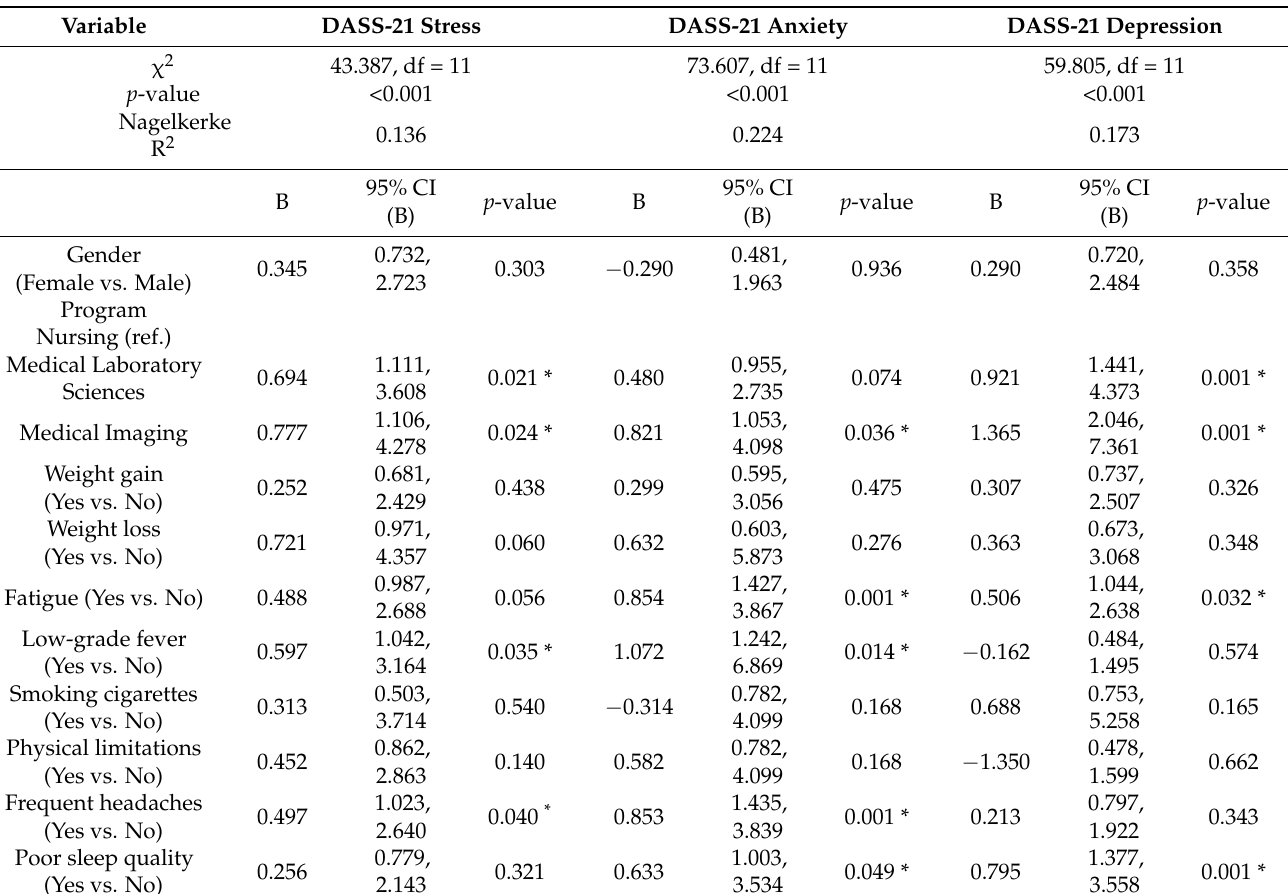
Table 5. Analysis of variables associated with stress, anxiety and